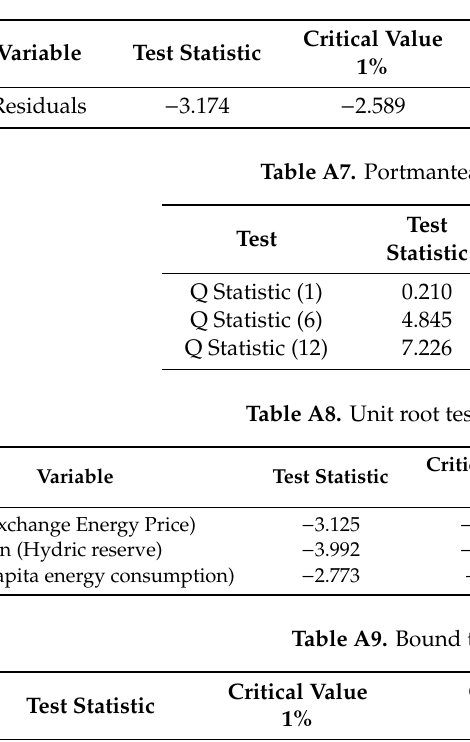
Table A6. Unit root test on residuals (ADF).